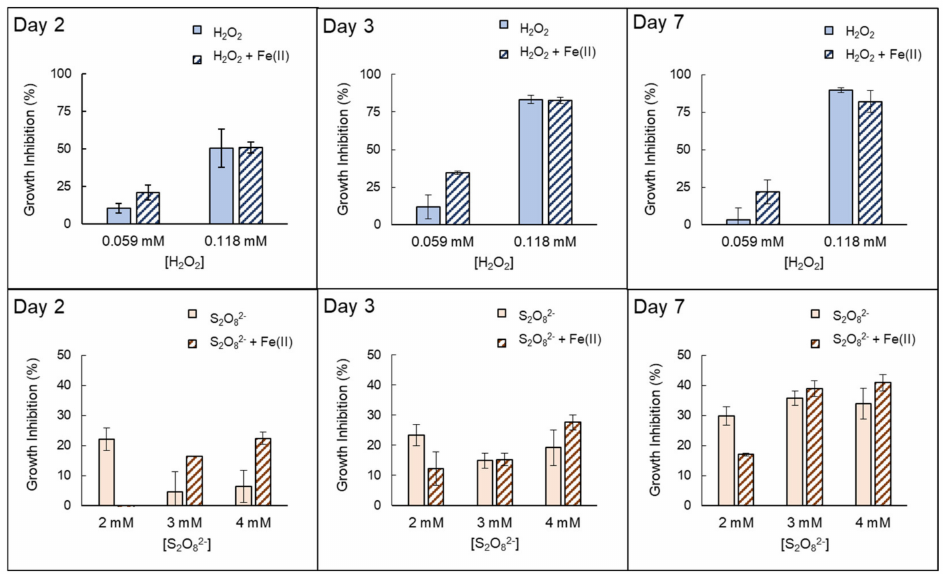
Figure 3. Specific growth inhibition (%) obtained at days 2, 3 and 7 for Anabaena sp. exposed to H 2 O 2 or S 2 O 82 − in the presence or absence of